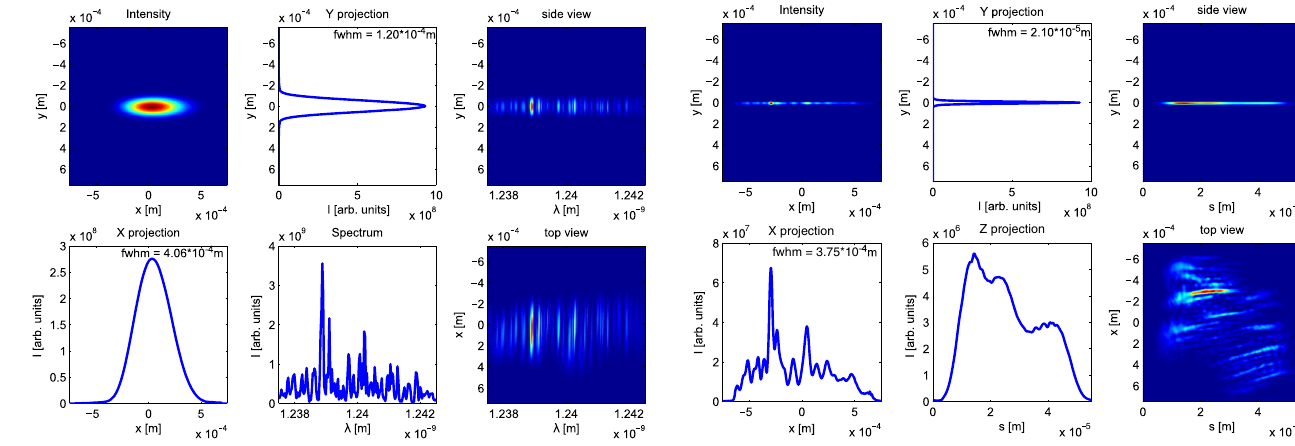
FIG. 11. Radiation distribution at the entrance of seeded undulator in time